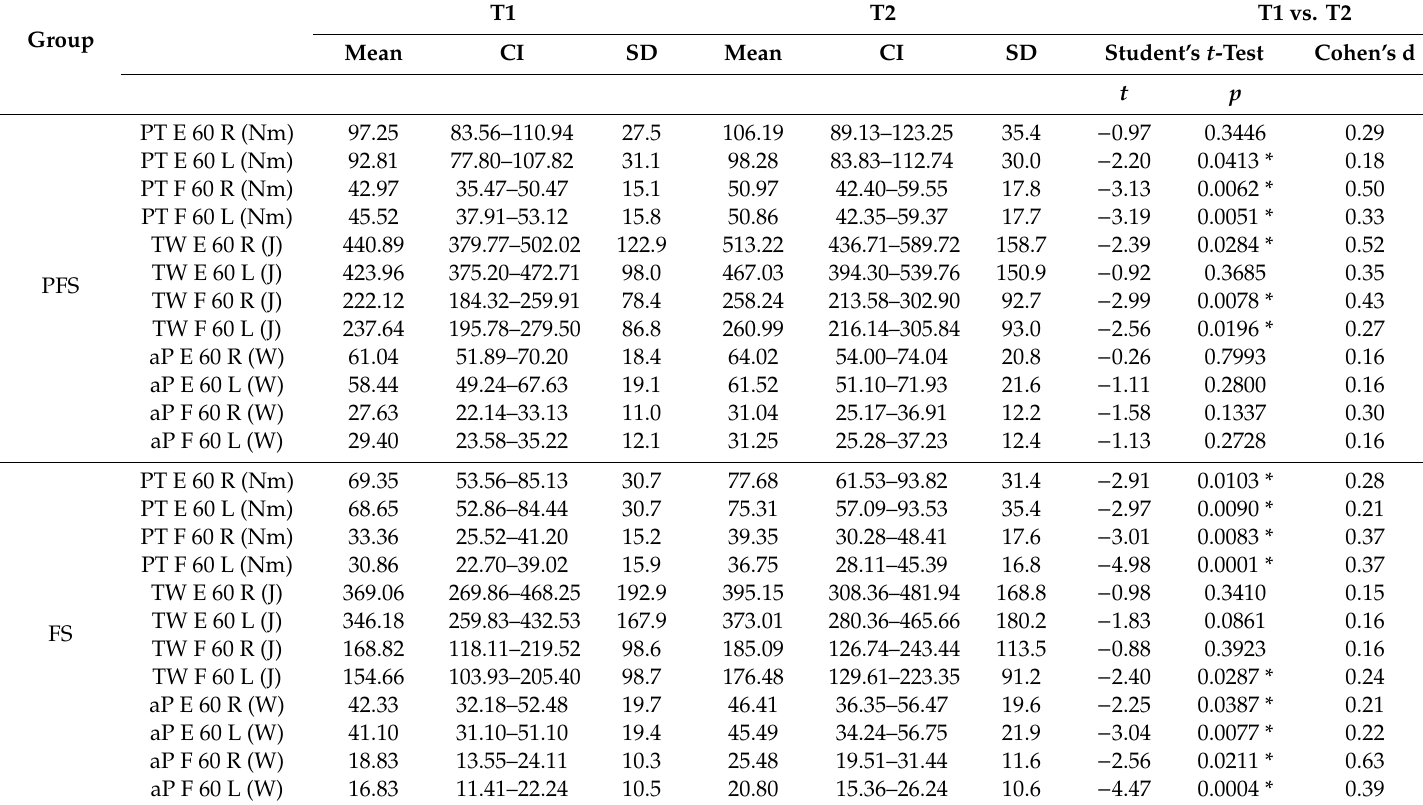
Table 4. Strength characteristics of the knee joint flexor and extensor muscles at a load of 60 ◦ / s, recorded before (T1) and after (T2) the 12-week training programme in both study groups (PFS and